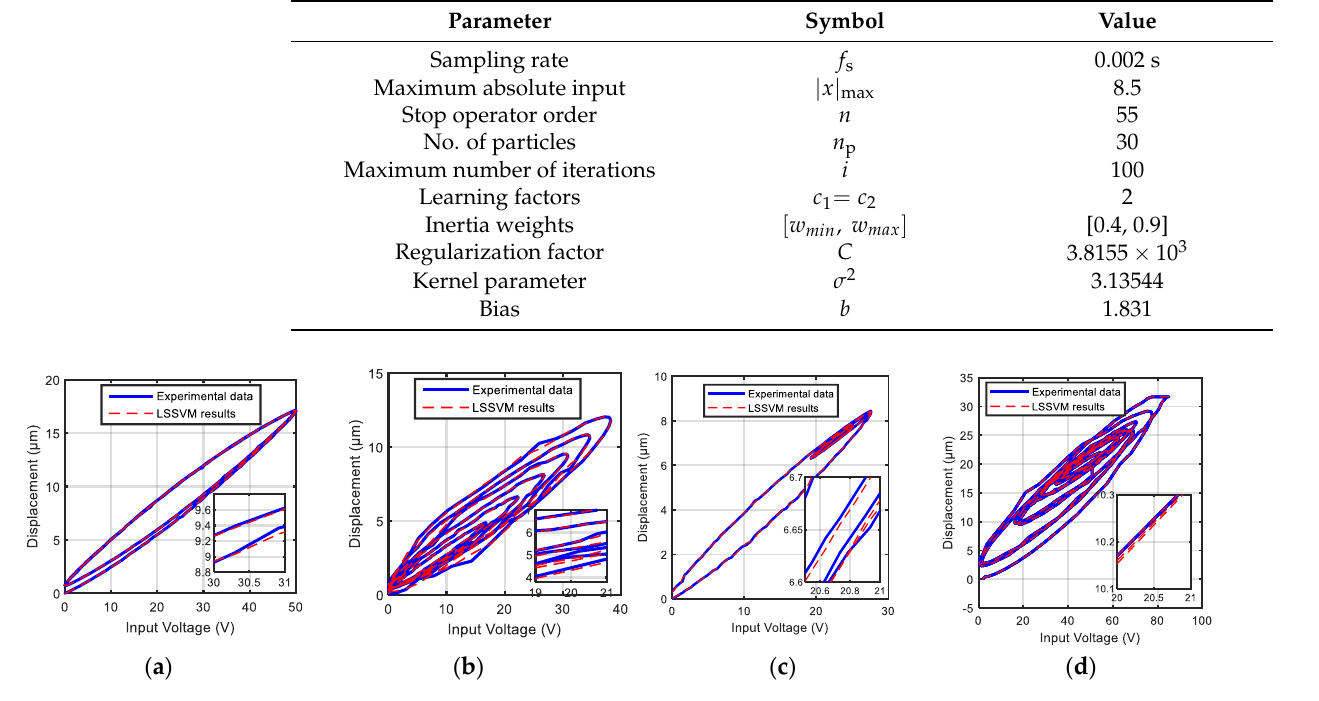
Figure 10. Simulation results of the PSO − LSSVM model on: ( a ) test data D; ( b ) test data E; ( c ) test data F; and ( d ) test data G.